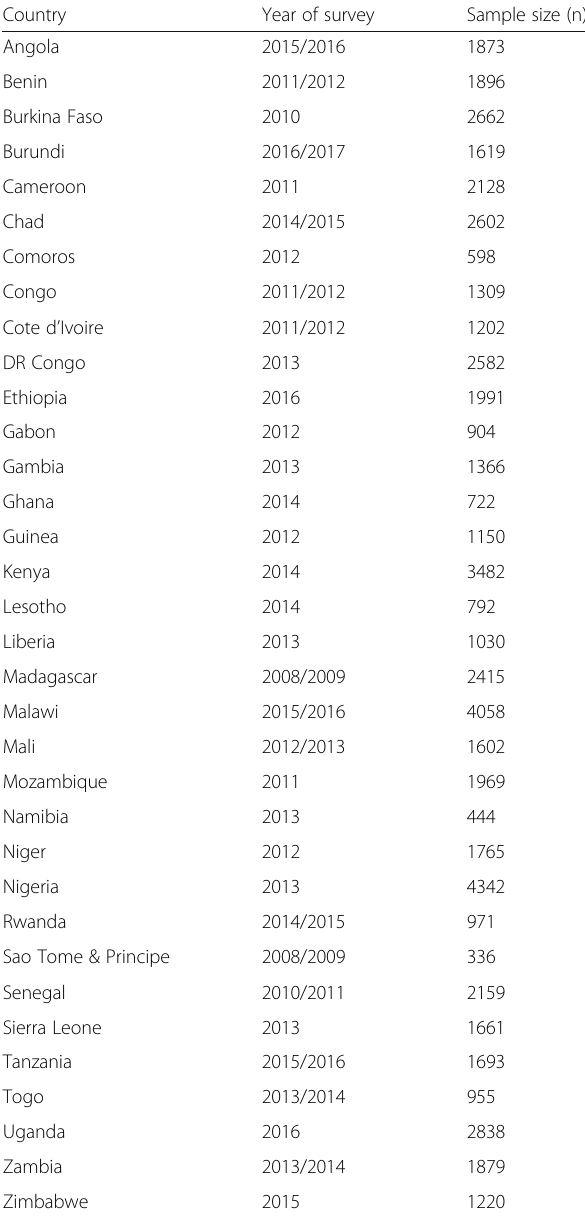
Table 1 Distribution of data among women aged 20 – 24 years in sub-Saharan Africa countries ( n = 60,215)